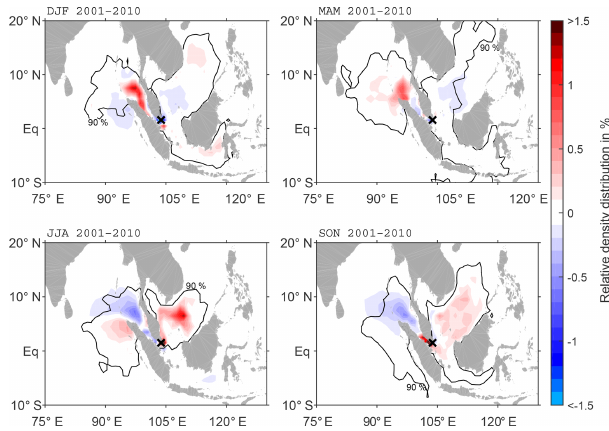
Figure 4. Annual mean area extent of DBP spread in the (a) Pearl River Delta and (b) Singapore based on 30%, 50%, 70% and 90% of the particles characterised by the highest density.